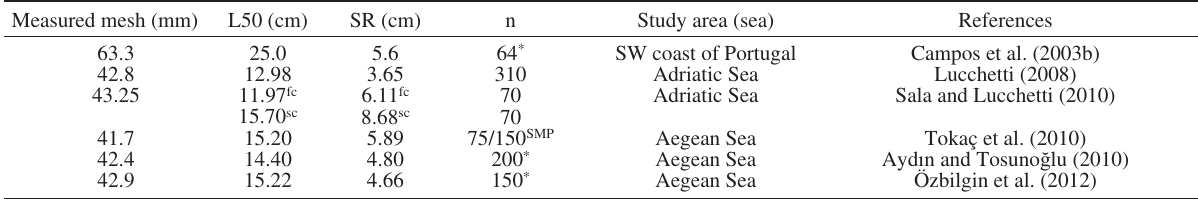
Table 2. – Experimental selectivity data for hake in square mesh codends. n denotes number of open meshes in codend circumference; * number of bars; fc , first cruise; sc , second cruise; SMP , square mesh top panel (SMP) codend: a combination of 75 square meshes on the top and 150 diamond meshes on the bottom panel, in total 225 meshes on its